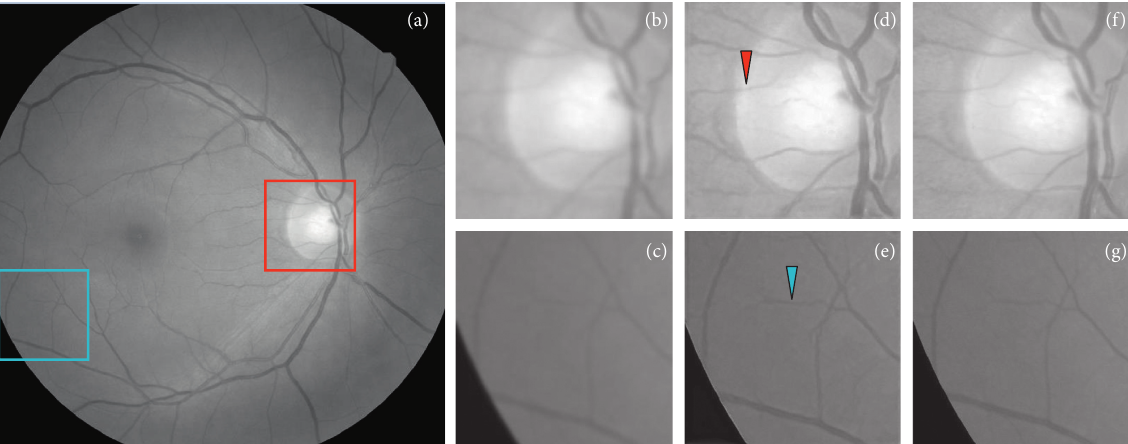
Figure 2: Experimental results on the simulated dataset. (a) Original uncropped image. (b, c) Blurry LR input. (d, e) The images processed by our method. (f, g) Ground truth. (b, d, f) Enlarged images of the red frame region enclosed in (a). (c, e, g) Enlarged images of the blue frame region enclosed in (a). Red arrow and blue arrow in (d) and (e) indicate the sharpened small blood vessels with our method.